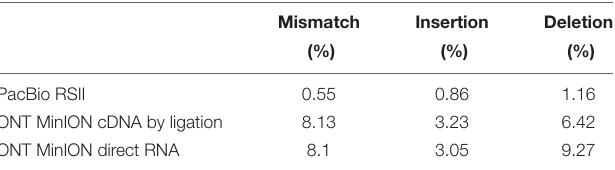
TABLE 1 | The percentage of mismatches, insertions and deletions for the ONT MinION cDNA, direct RNA, and the PacBio sequencing platforms. Mismatch Insertion Deletion (%) (%) (%) PacBio RSII 0.55 0.86 1.16 ONT MinION cDNA by